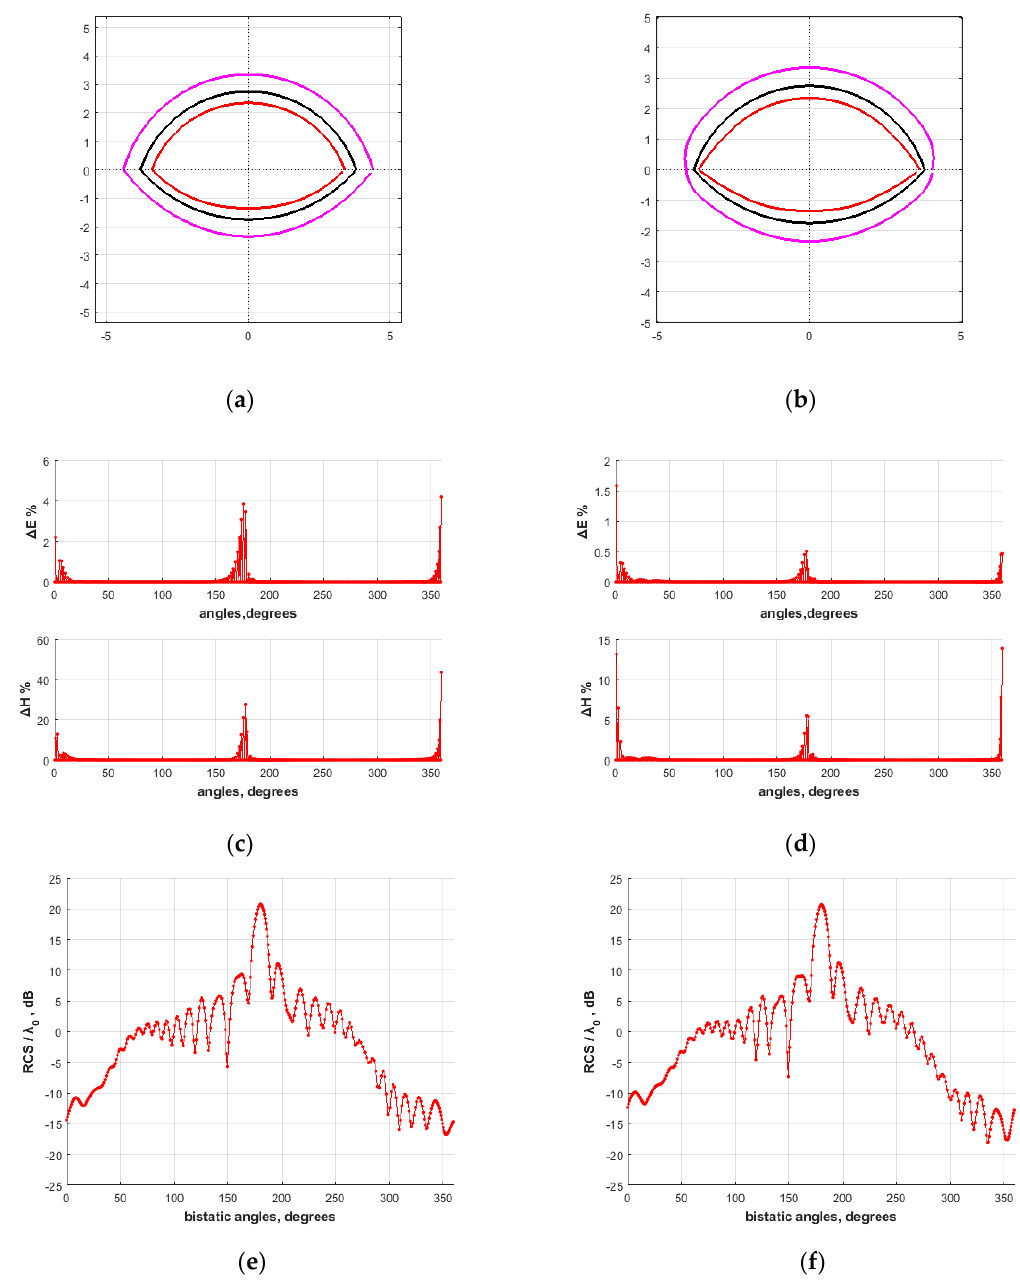
Figure 12. Large arc displacement (cid:1856) = 0.7(cid:2025) = 2.1(cid:2019): ( a ) geometry and conformal auxiliary surfaces; ( b ) geometry and improved auxiliary surfaces; ( c ) conformal (cid:1986)(cid:1831) and (cid:1986)(cid:1834) error; ( d ) improved (cid:1986)(cid:1831) and (cid:1986)(cid:1834) error; ( e ) conformal RCS; and ( f ) improved RCS.